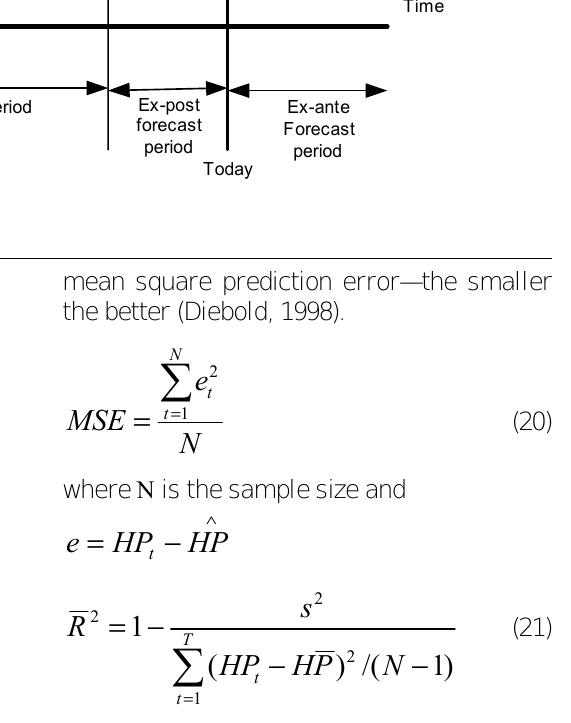
Figure 4: Periods of